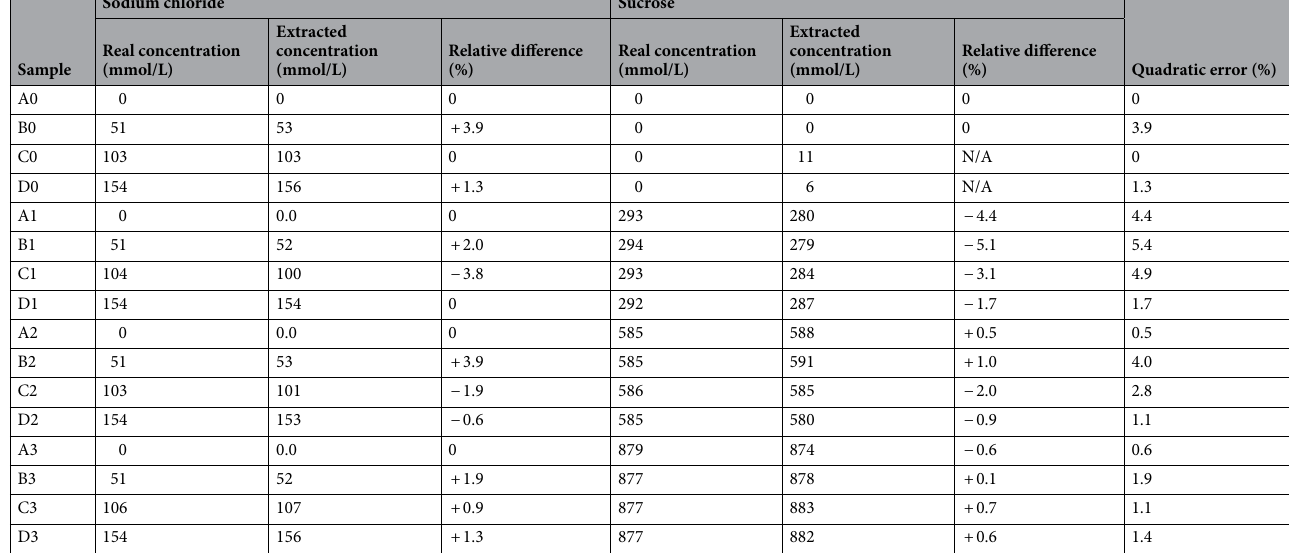
Table 7. Summary of extracted concentrations using equations derived from measured results (Eqs. (17) and